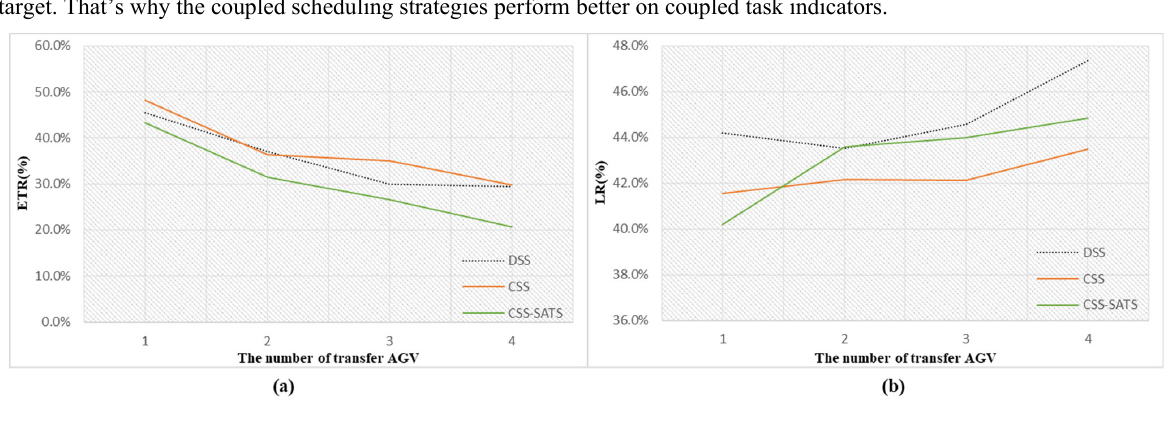
Fig. 10. The performance in ETR (a) and LR (b) in experiment